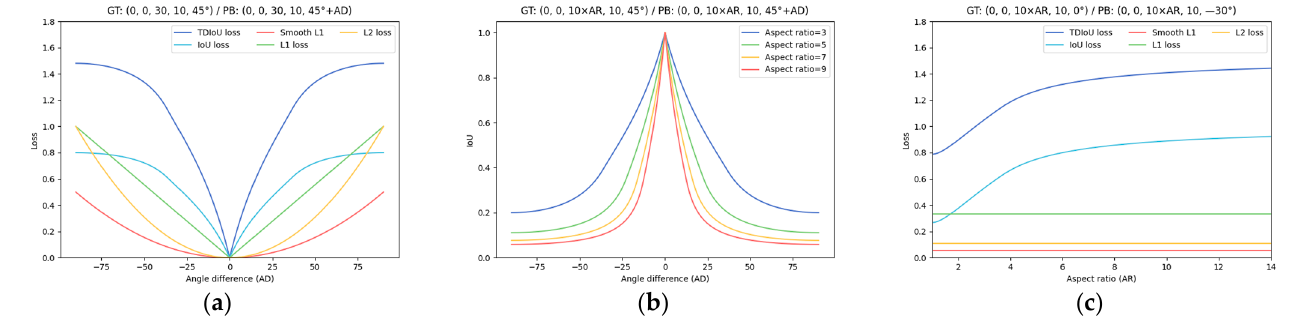
Figure 4. Loss-metric inconsistency. All ground truths (GT) and predicted boxes (PB) are represented as ( cx , cy , w , h , and θ ) under the long-edge definition. ( a ) Regression loss variations versus angle differences (AD); ( b ) rotational IoU variations versus angle differences under different aspect ratios (AR); ( c ) regression loss variations versus aspect ratios.